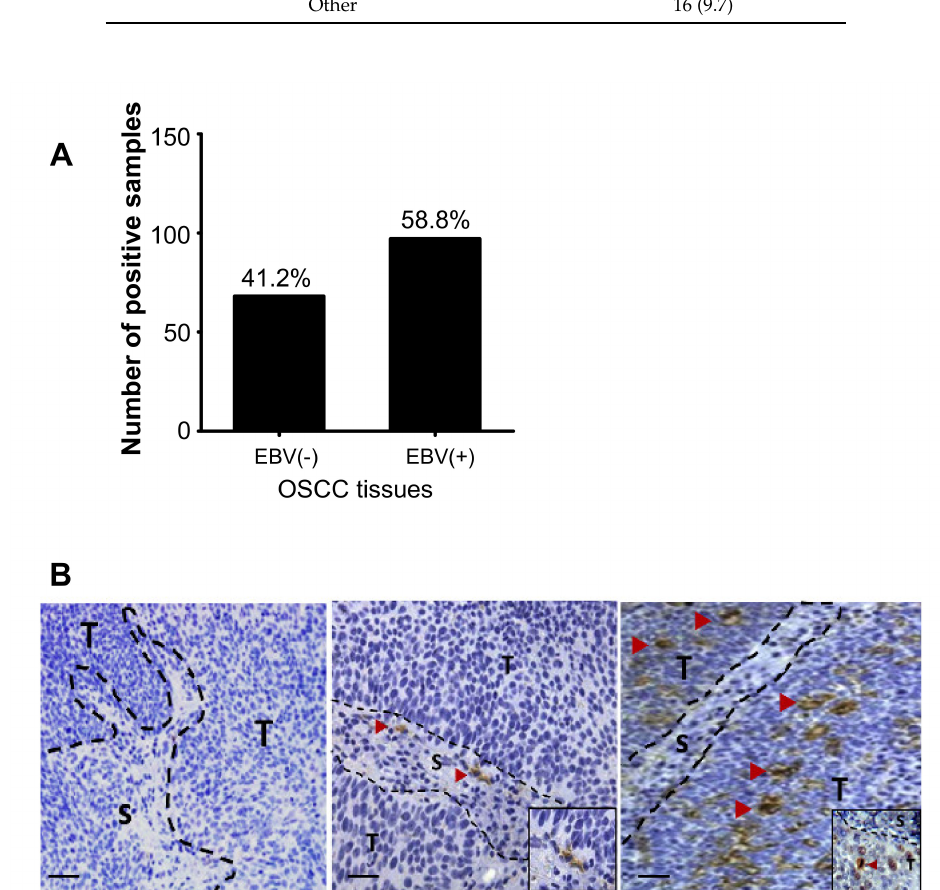
Figure 1. Epstein–Barr virus (EBV) infection detected in OSCC tissues. The presence of EBNA1 and / or LMP1 DNA in OSCC tissues was examined by real-time PCR ( A ). EBNA1 and / or LMP1 positive cases were subjected to further staining for EBER using EBER-ISH. EBER staining divided OSCC into three groups: EBER-negative OSCC ( B ). EBER-staining in OSCC tissues. No EBER-signals either in stromal and tumoral regions (left), EBER-positive infiltrating lymphocytes (Red arrowhead, middle), EBER-positive tumor cells (Red arrowhead, right). EBER positive signals are stained as dark brown in the nuclei and indicated by arrowheads. S: stromal cells, T: tumor cells. Scale bar: 200 µ